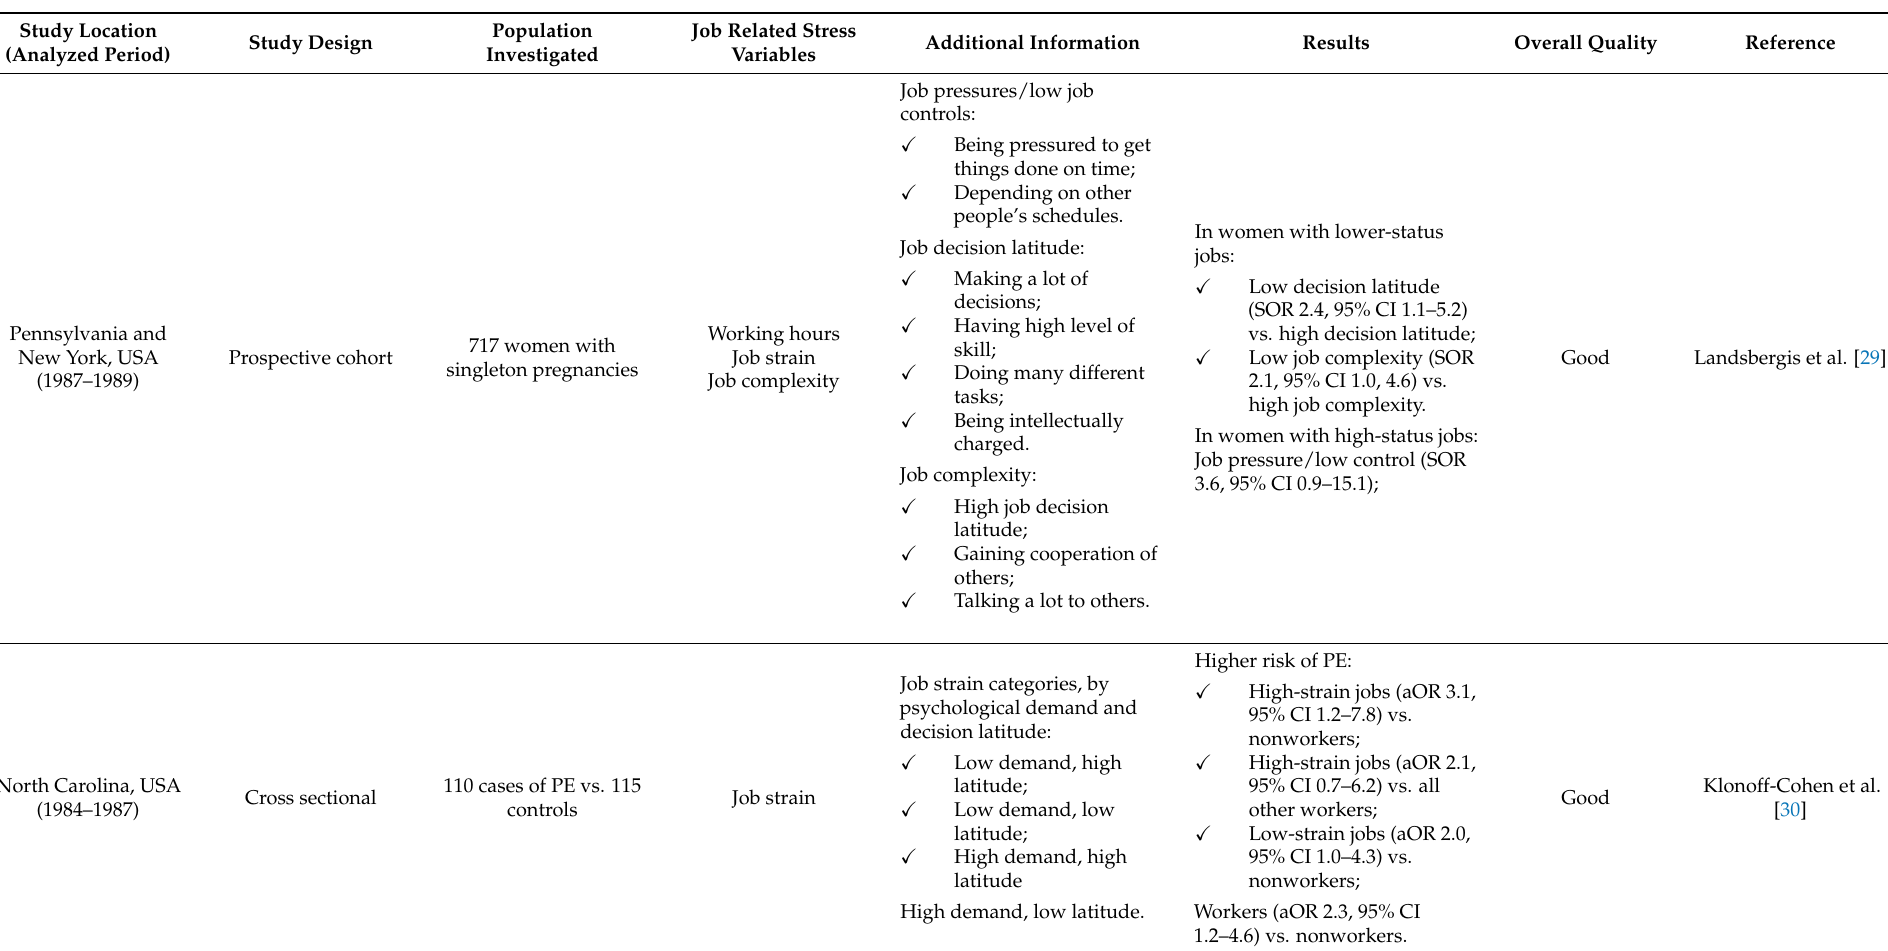
Table 6. Studies assessing the relationship between hypertensive disorders in pregnancy (HDP), including preeclampsia (PE) and gestational hypertension (GH), and exposure to job related